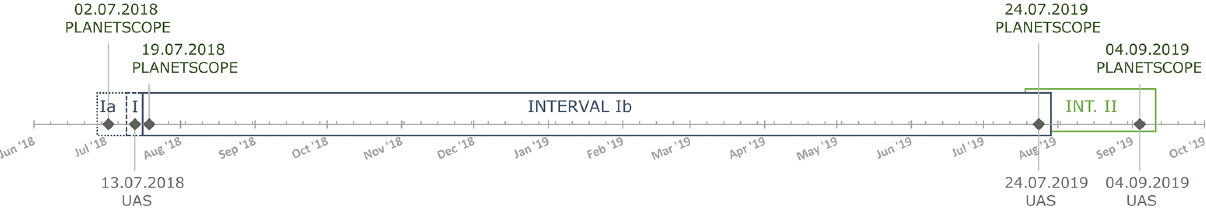
Figure 4. Acquisition dates of UAS and PlanetScope images within the investigated time period. Calculated interval I for UAS images (13 July 2018–24 July 2019, 376d) and interval Ib for PlanetScope images (19 July 2018–24 July 2019, 370d) and interval II for UAS and PlanetScope images (24 July–4 September 2019, 42d). Note that the Ia PlanetScope interval was